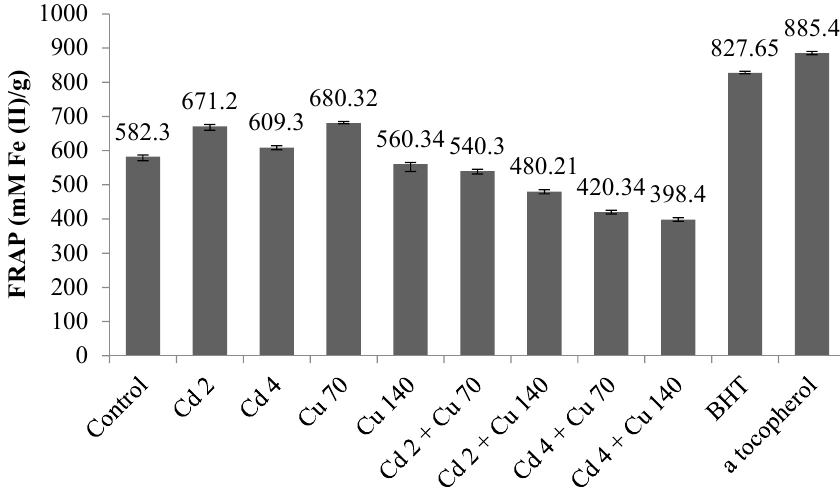
Figure 3. The impact of cadmium and copper on FRAP activity of G. procumbens . Bars represents standard error of differences between the means. N = 15. Cd 2 = cadmium 2 mg/L; Cd 4 = cadmium 4 mg/L; Cu 70 = copper 70 mg/L; Cu 140 = copper 140 mg/L; Cd 2 + Cu 70 = cadmium 2 mg/L + copper 70 mg/L; Cd 2 + Cu 140 = cadmium 2 mg/L + copper 140 mg/L; Cd 4 + Cu 70 = cadmium 4 mg/L + copper 70 mg/L; Cd 4 + Cu 140 = cadmium 4 mg/L + copper 140 mg/L.